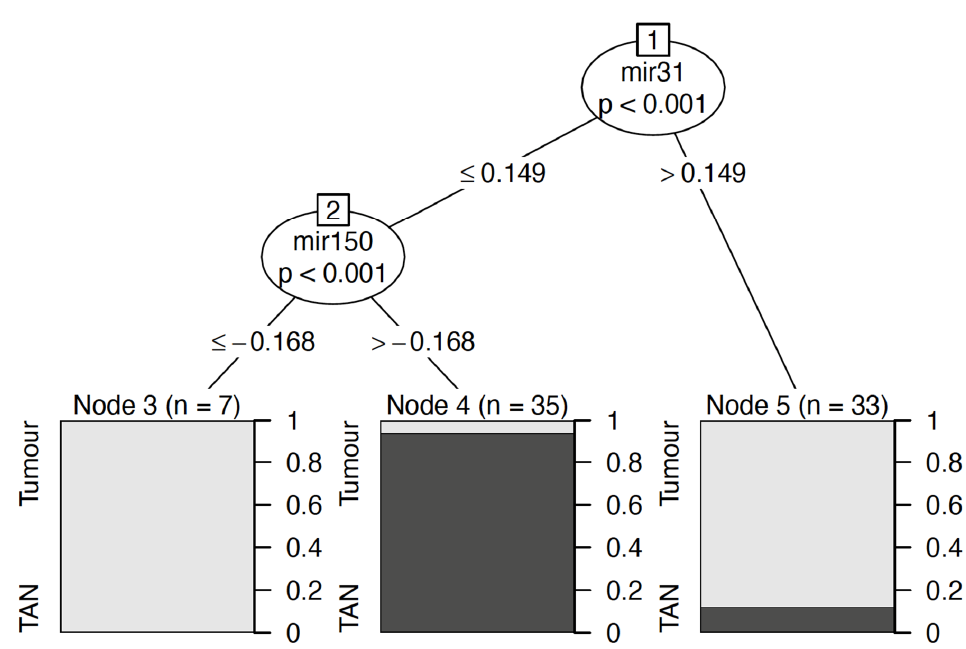
Figure 2. Regression tree illustrating the clinical use of miR-31 and miR-150 measurement to differentiate tumour tissue from tumour-associated normal tissue.